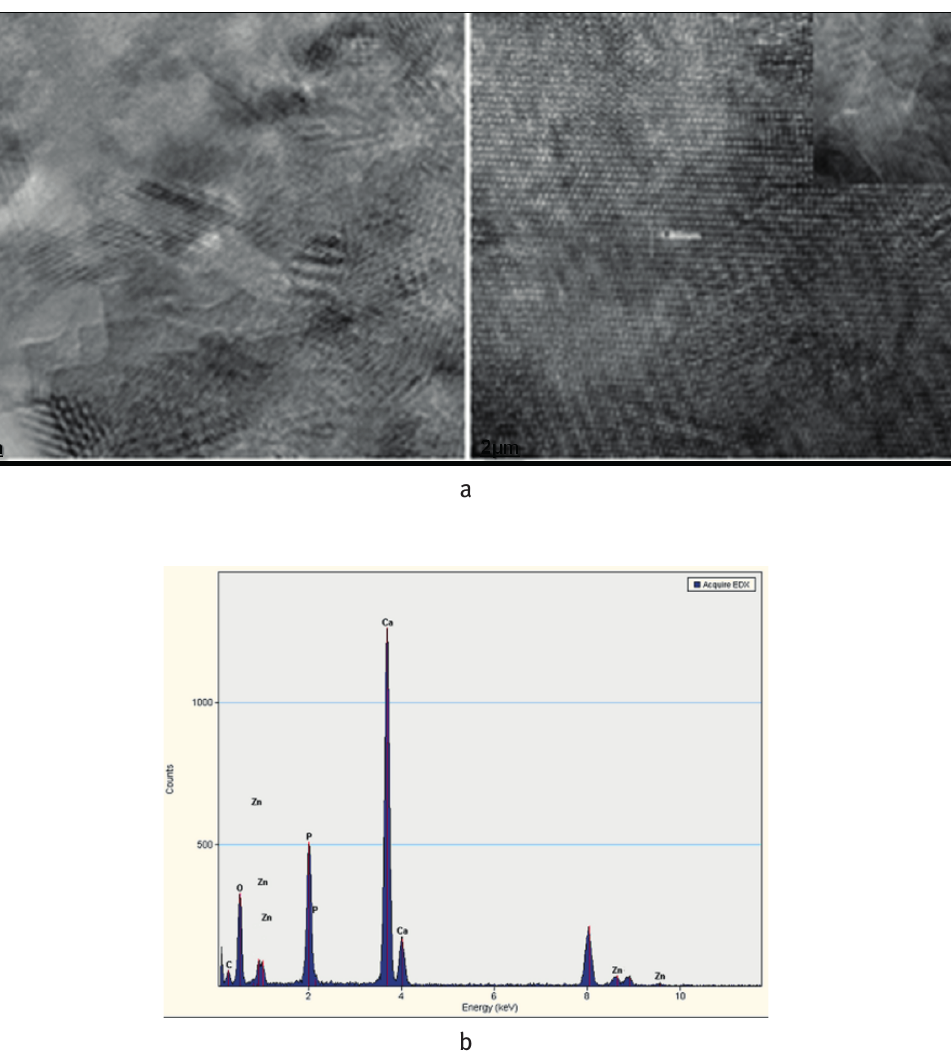
Figure 7: (a) HRTEM comparative image of HA and HA-ZnO, (b) EDAX spectra of HA-ZnO sample treated with